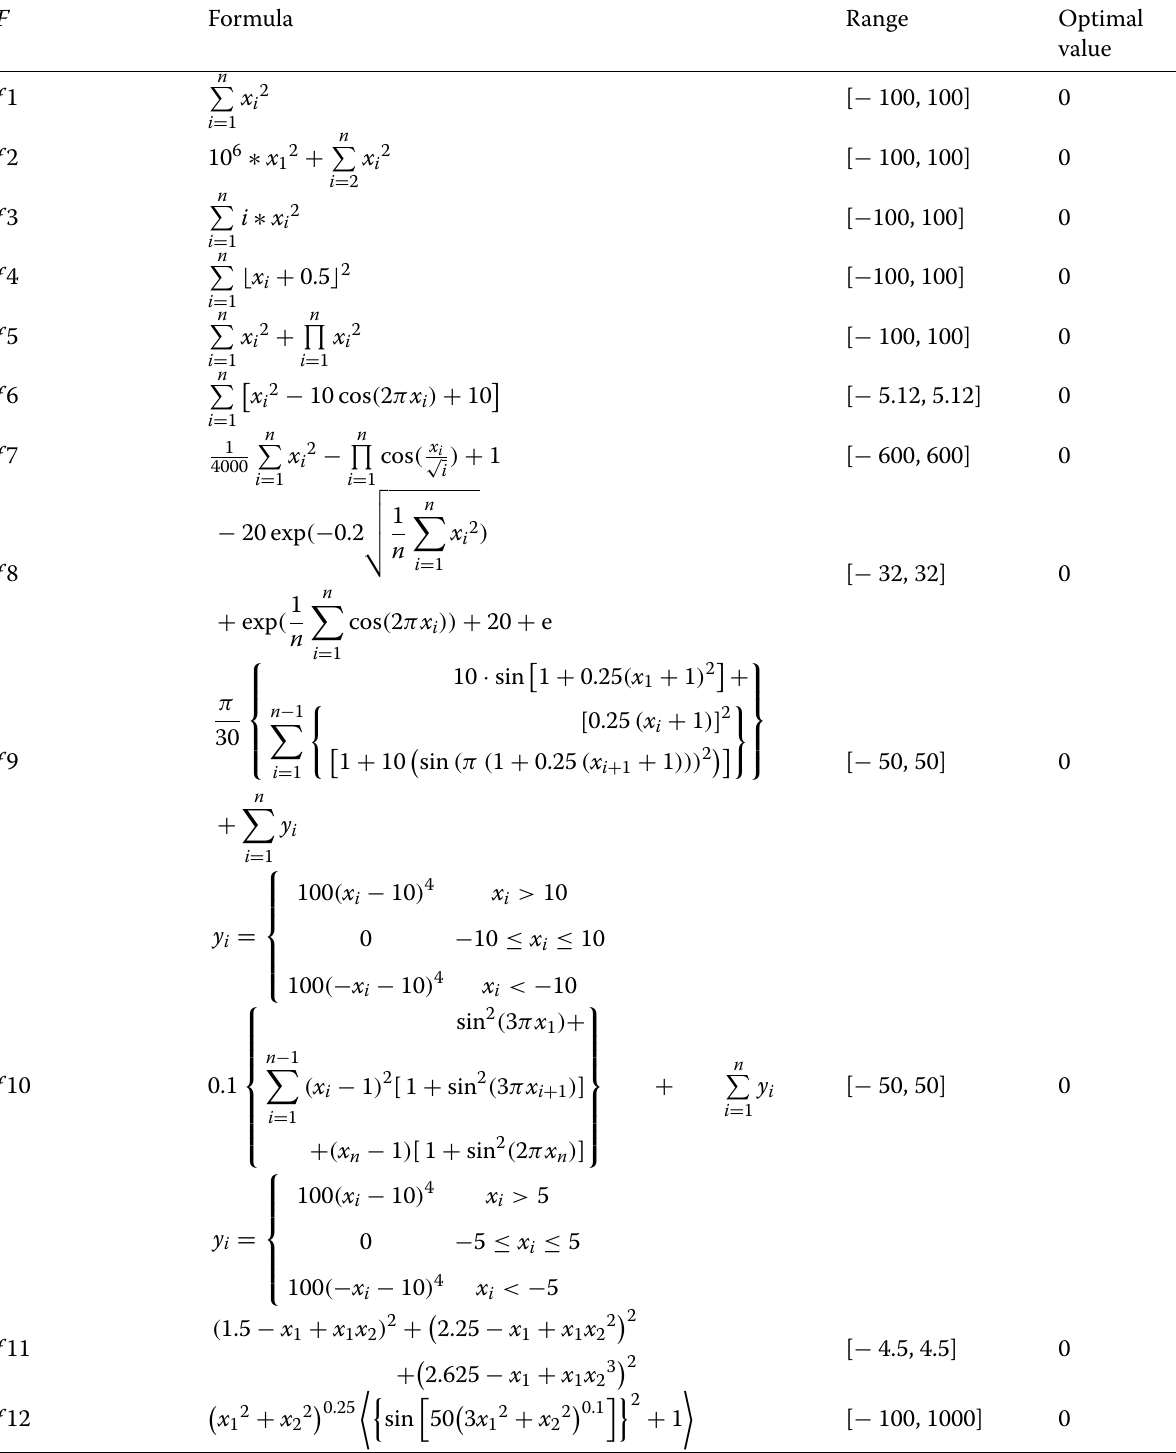
Table 1 Detailed information on the 12